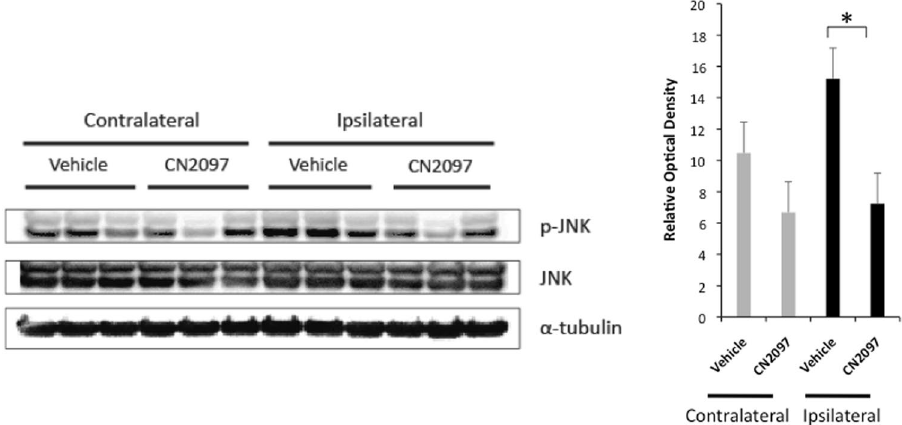
Figure 2. CN2097 reduces JNK activity in the injured ipsilateral hippocampus. Western blots showing that CN2097 significantly lowered the level of phosphorylation of JNK (p-JNK) in the ipsilateral hippocampus 24 h after TBI. The bar graph illustrates quantitative data of the optical density of p-JNK normalized to JNK (mean ± SEM, * p < 0.05). Animals were injected i.p. with CN2097 (10 mg/kg) or vehicle (0.9% NaCl) at 1 and 2 h post-TBI (n = 3 rats/group), and the hippocampal samples were collected at 24 h after TBI. The images shown are cropped. The full-length original images are shown in Fig.